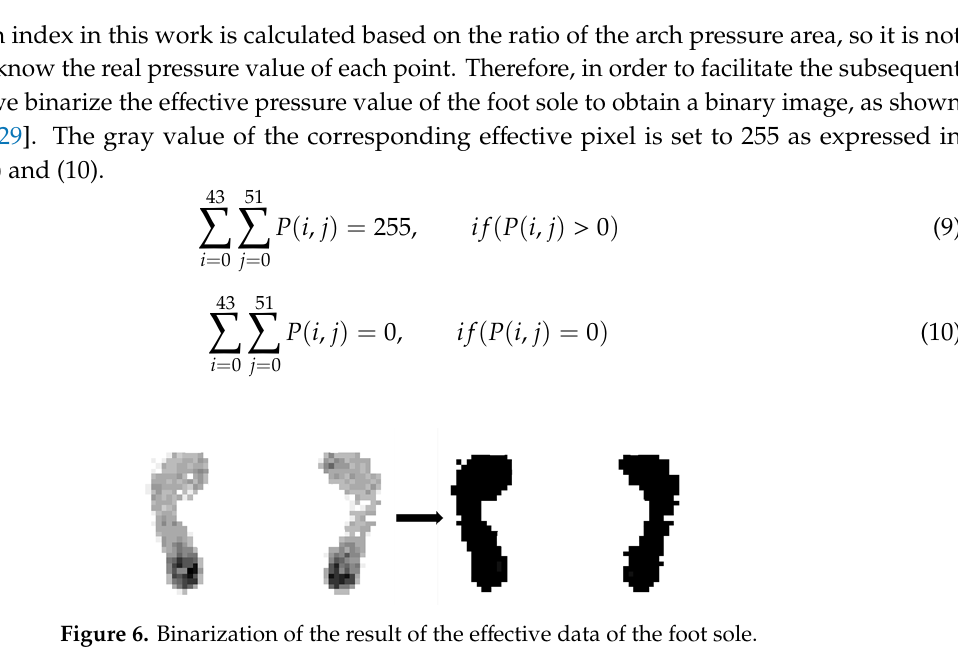
Figure 6. Binarization of the result of the effective data of the foot sole.